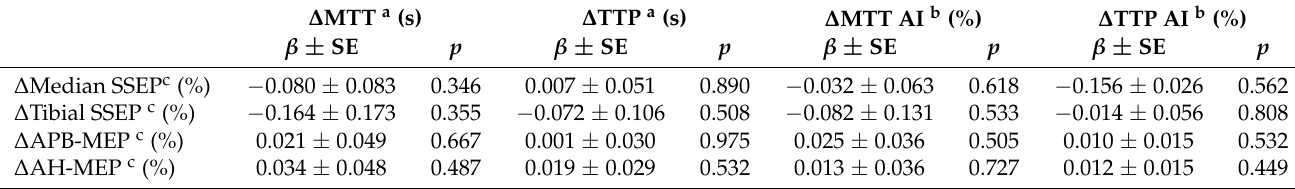
Table 5. Univariate analysis of simple linear regression model in the MB